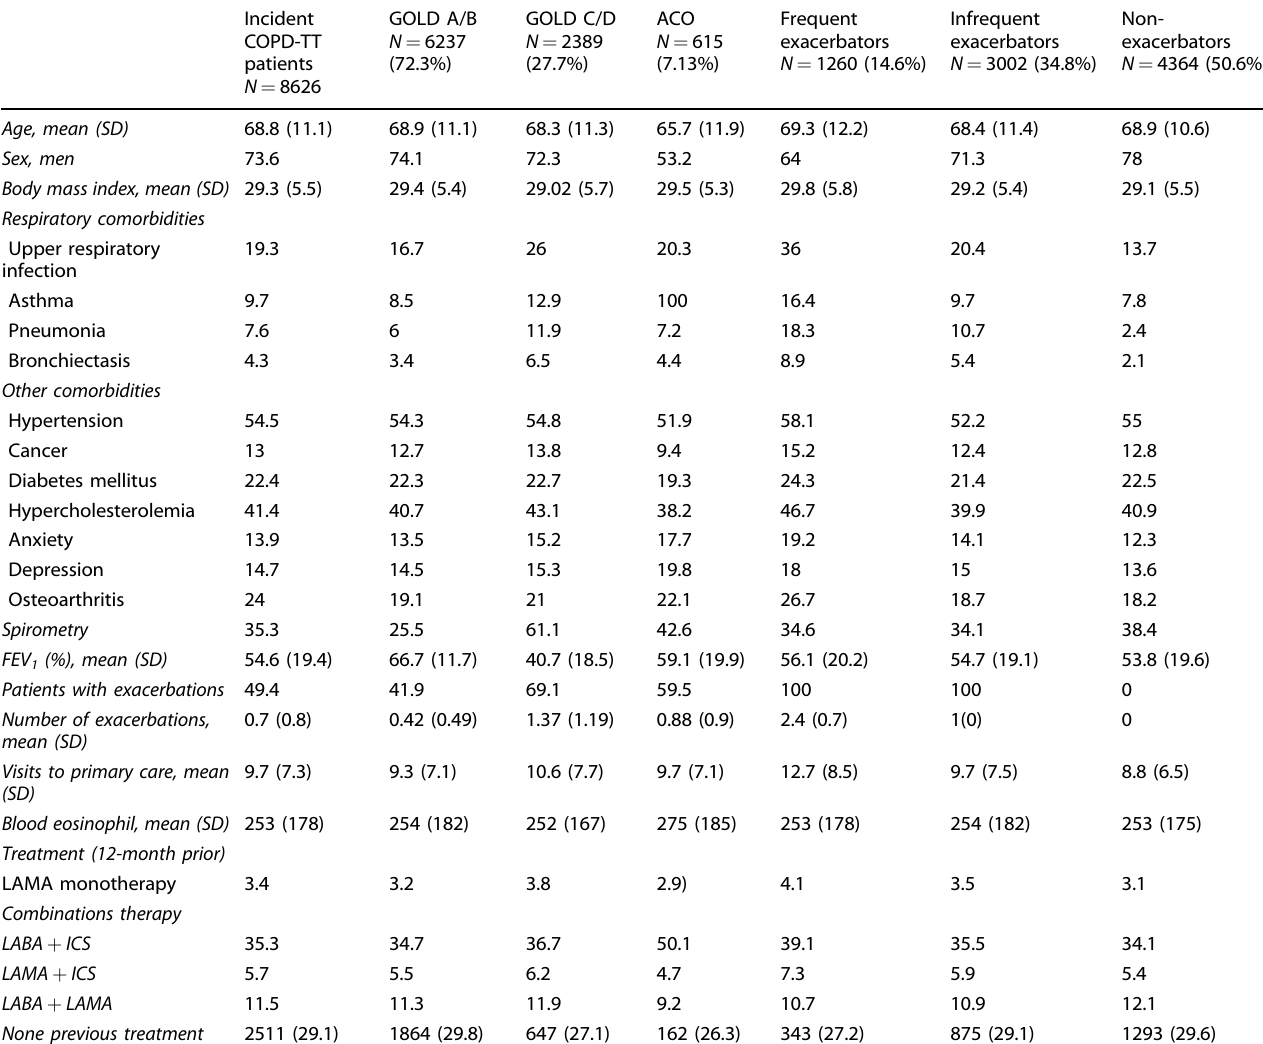
Table 2. Characteristics of incident TT patients who initiated treatment at or after COPD diagnosis and according to severity of disease and clinical phenotypes ( n = 8626).